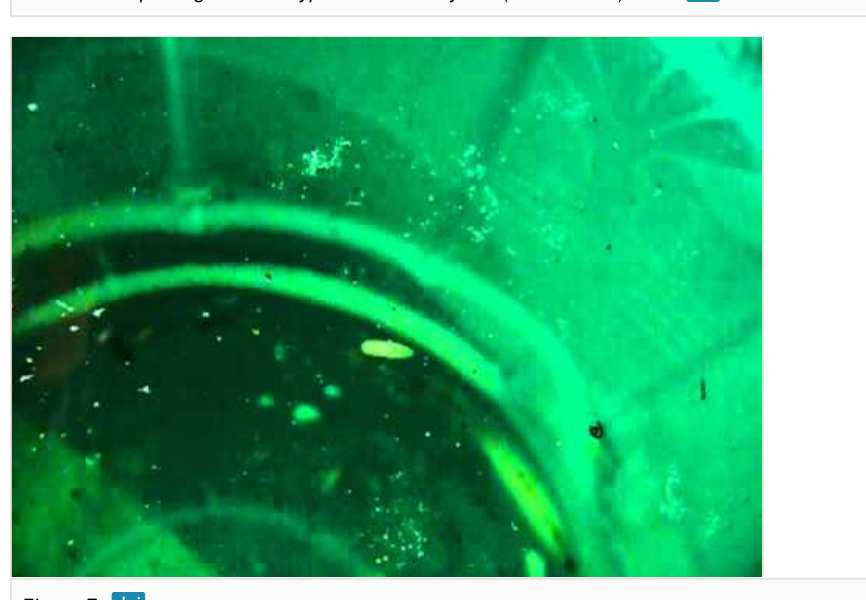
Figure 6. Dispersal behaviour of third instar Caiusa larvae. a : Larva descending from a Chiromantis simus (Annandale) nest using a thin thread (arrows). b : Larvae dispersing from a Polypedates leucomystax (Gravenhorst) nest.